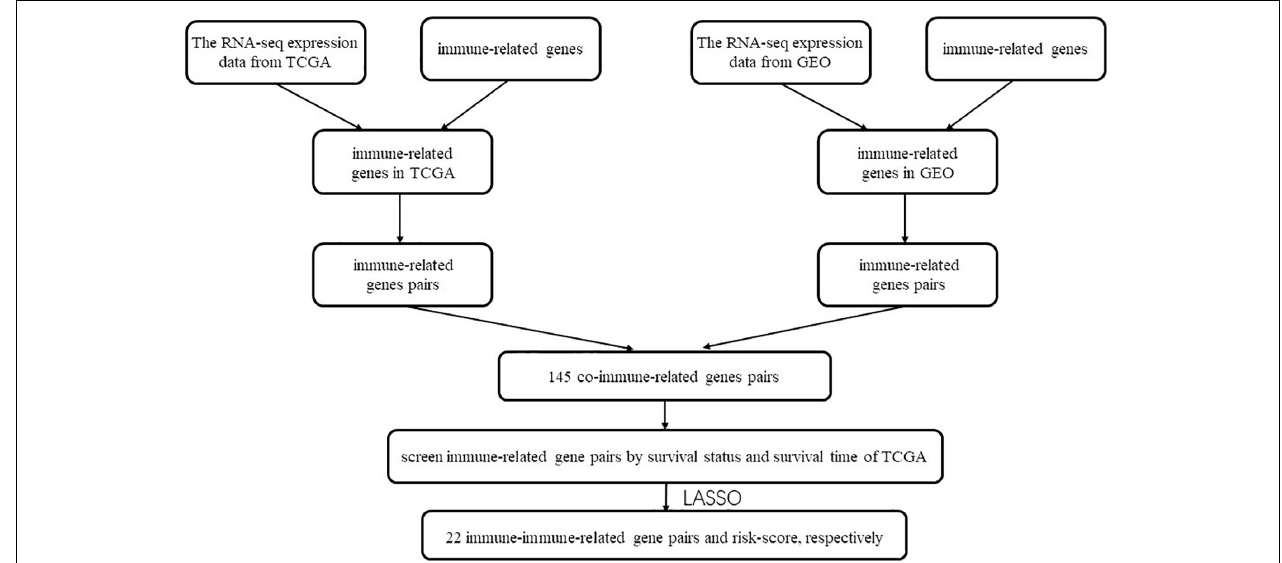
FIGURE 1 | Flow chart of this study.